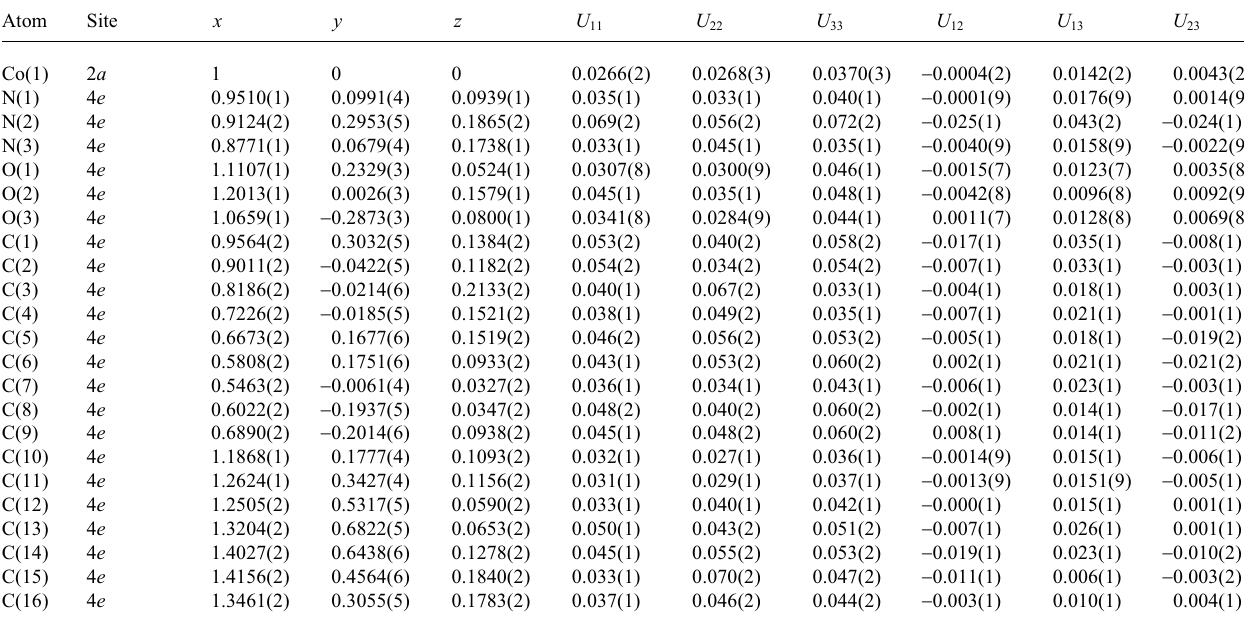
Table 3. Atomic coordinates and displacement parameters (in Å 2 )